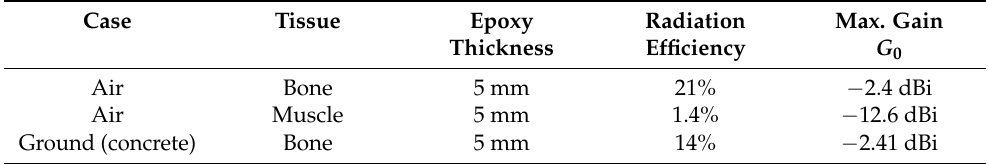
Table 1. Simulated efficiencies in different scenarios